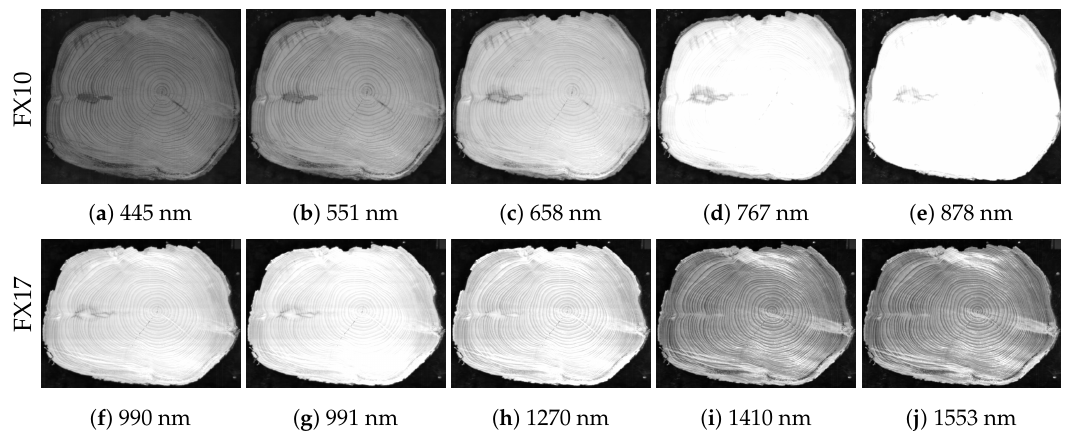
Figure 2. Exemplary cross-section (CS)-Images from different hyperspectral bands of the wood disc #E001B.